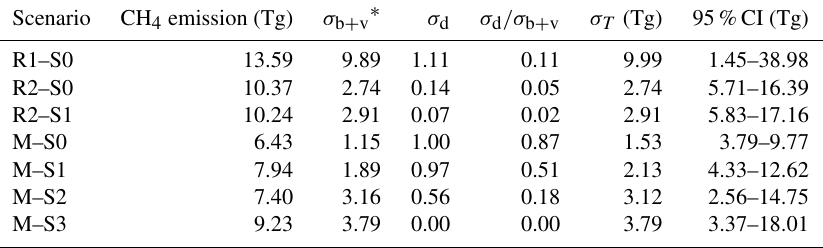
Table 3. Methane emissions inventory and the uncertainties caused by model imperfection and errors in model input data. Scenario